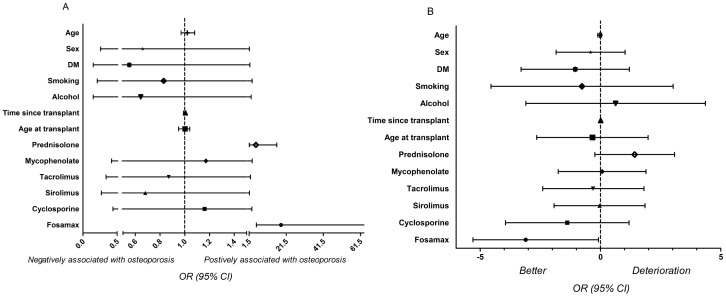
Clinical variables associated with bone condition change.A binary (non-osteoporosis and osteoporosis in follow-up) logistic regression analysis was performed to identify the variables associated with osteoporosis. The dependent variable was non-osteoporosis or osteoporosis. The independent variables were age, sex, DM, smoking, alcohol consumption, age at transplantation, time since transplant, use of immunosuppressive agents and use of Fosamax. Both the use of prednisolone (odds ratio [OR], 5.18; 95% confidence interval [CI], 1.6–16.4; p = 0.005) and the use of Fosamax (OR, 18.75; 95% CI, 5.42–64.76; p<0.001) were associated with the symptoms of osteoporosis (Figure 2A). In an ordinal logistic regression with multivariate analysis of the change of bone condition (grade 1, changed to the better; grade 2, no change; and grade 3, deterioration, as defined by WHO criteria and clinical variables), after adjusting for age, sex, status of diabetes (DM), smoking, alcohol consumption, time since transplant, age at transplant, and use of prednisolone, the use of Fosamax (OR, −3.115; 95% CI, −5.364 to −0.866; p = 0.007) was found to be associated with a positive prognosis (Figure 2B).